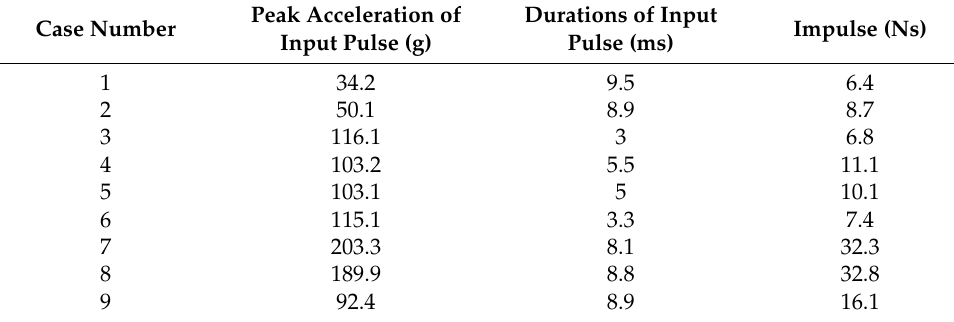
Table 2. Parameters of nine drop